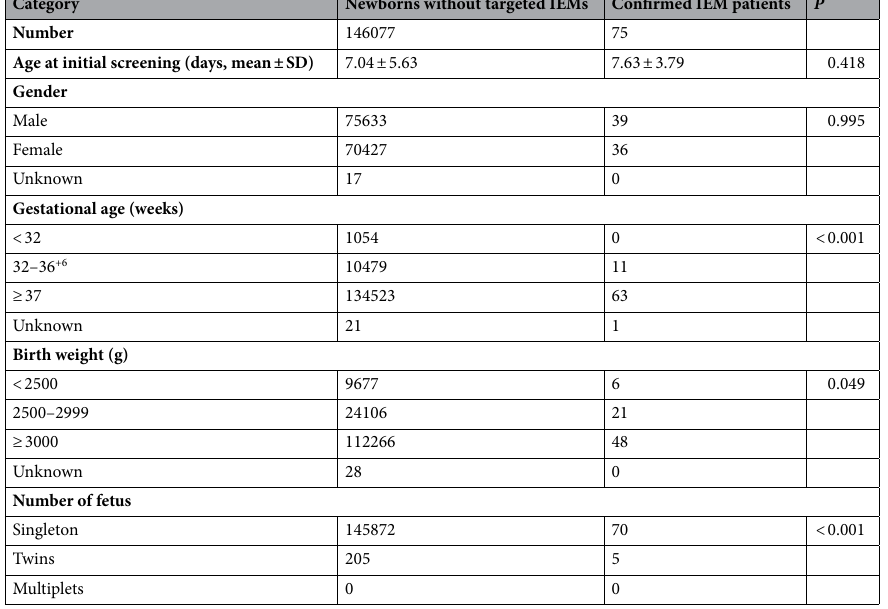
Table 1. Baseline characteristics of newborns enrolled by expanded newborn screening